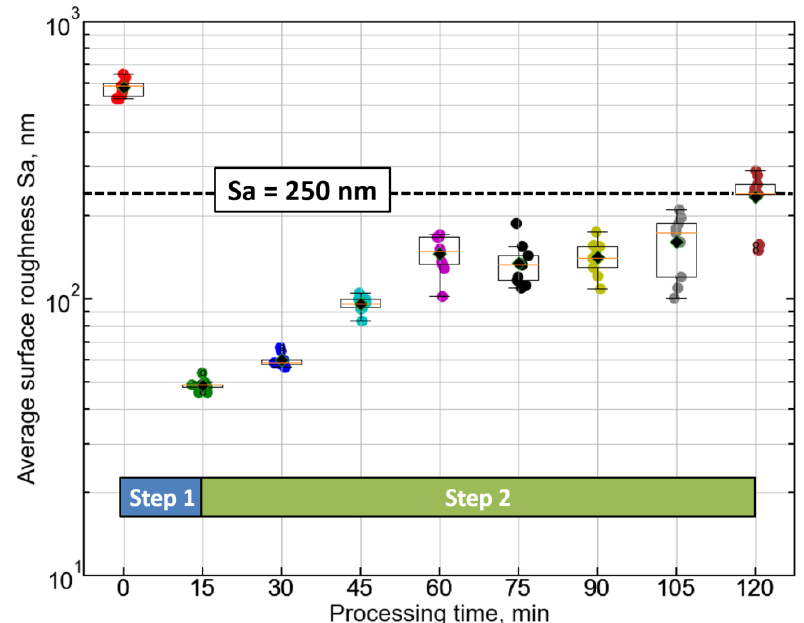
Figure 12. The calculated number of embedded particles versus polishing time.